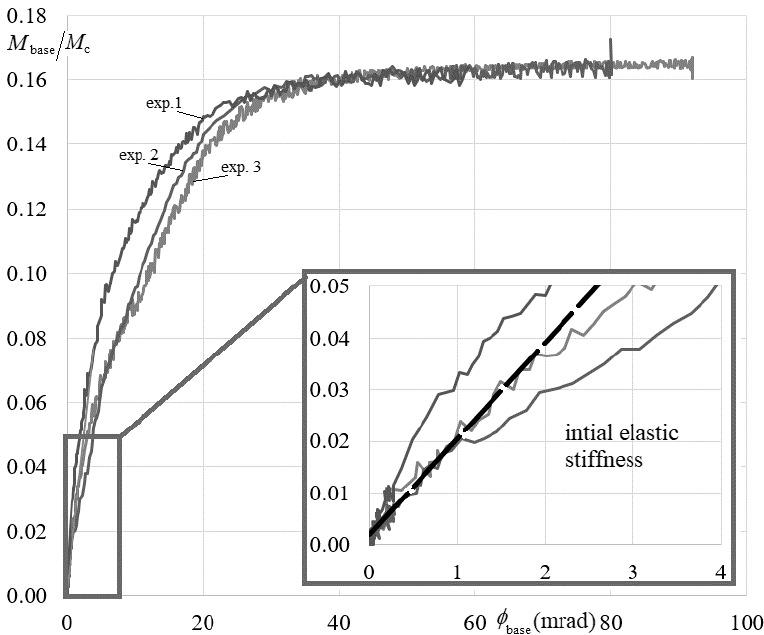
Figure 6. Relationship between the non-dimensional moment versus the rotation for base-plate connections and design value of the elastic stiffness.